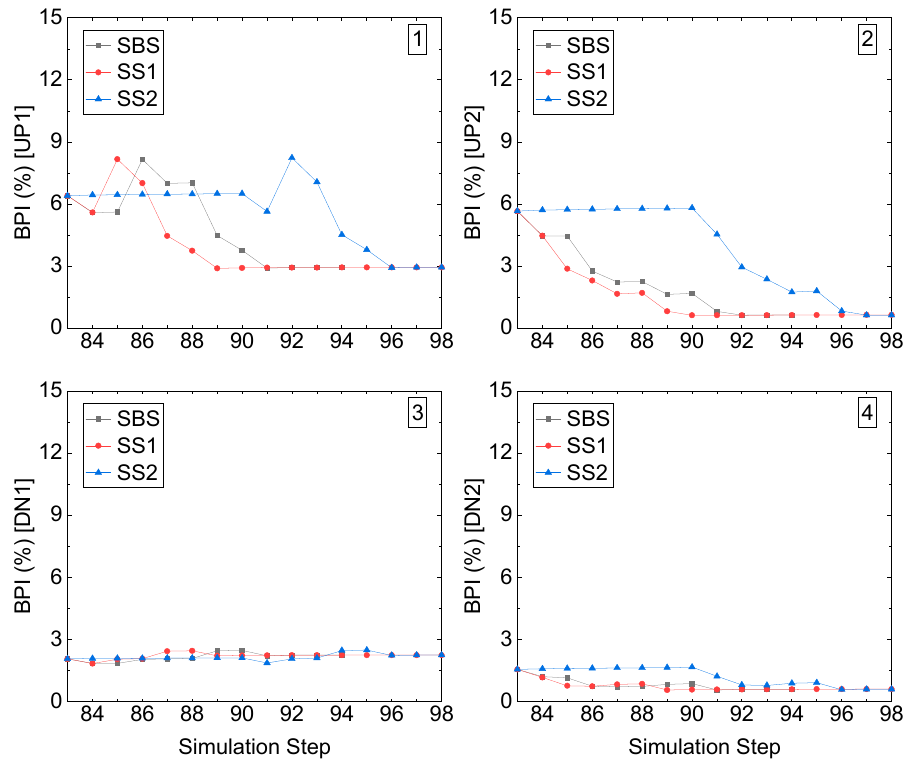
Figure 18. BPI value of the middle stope access to the undercut in Sill-1. DN2, the BPI is even under 1.5%.